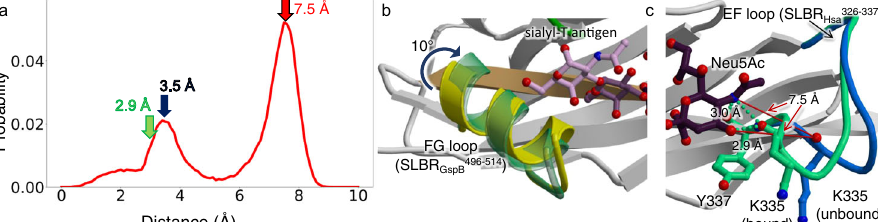
Fig. 5 Conformations associated with SLBRs bound to sialoglycans. a Probability of distance distribution between the position of the Neu5Ac O4- hydroxyl in sTa and the SLBR Hsa K335 backbone carbonyl, as calculated by MD simulations. A bimodal distribution of distances exhibit maxima at 7.5 Å ( red arrow), which re fl ects the unliganded crystal structure, and at 3.5 Å ( navy arrow), which approaches the liganded crystal structure. The formation of the hydrogen-bond between the SLBR Hsa K335 carbonyl and Neu5Ac likely shifts the conformational equilibrium to a pose that supports the 2.9 Å distance ( light green arrow) observed in the bound state. b The FG loop of SLBR GspB-Siglec rotates 10° upon sTa binding. The position in the unbound structure is shown in yellow and the position in the bound structure is shown in light green . c The EF loop of SLBR Hsa adjusts to promote formation of hydrogen-bonding interactions between SLBR Hsa K335 and the Neu5Ac of sTa. The position of this loop in the unbound structure is shown in blue , and the position occupied in the bound structure is shown in light green . The distance between the SLBR Hsa K335 backbone carbonyl and the position of the Neu5Ac O4-hydroxyl of the unliganded state are shown in red lines and match the 7.5 Å distance calculated by MD simulations (panel a ). The distance between the SLBR Hsa K335 backbone carbonyl and the position of the Neu5Ac O4-hydroxyl is shown in light green dots